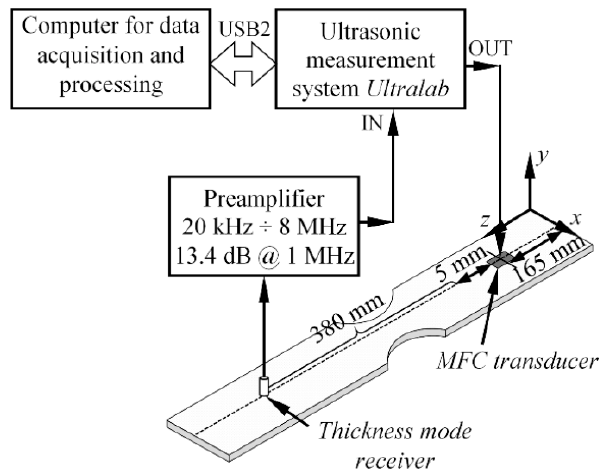
Figure 10. The experimental set-up investigating source influence on guided wave generation.